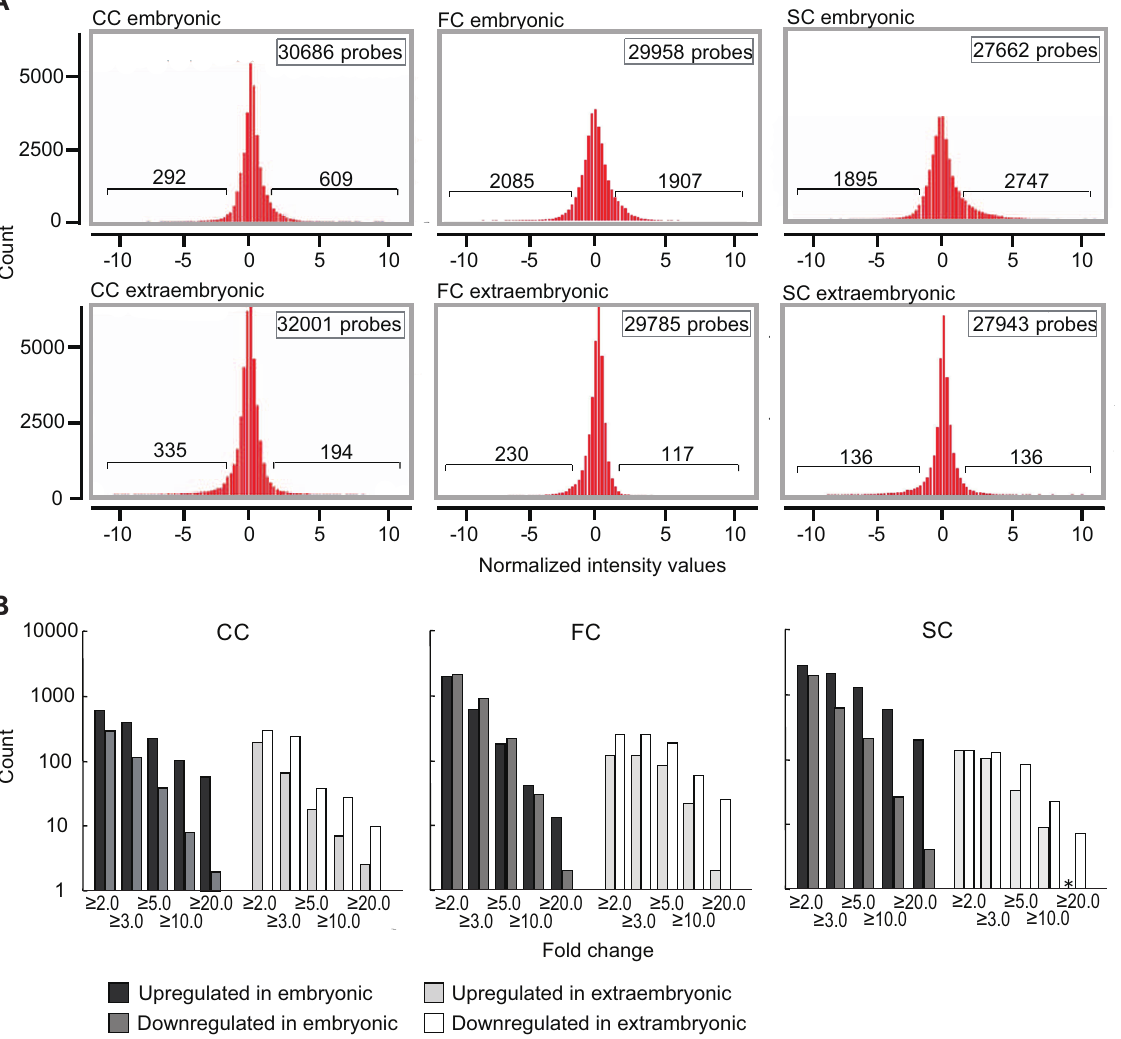
Figure 3. Fold change analysis of gene expression profiles of embryonic and extraembryonic samples. Fold change analysis with a cutoff of f . 2 identified the number of differentially expressed genes (DEGs) in SCNT-derived samples compared with IVF-derived controls. ( A ) Histogram showing the distribution of DEGs classified by the relative values compared with the IVF-derived controls. The embryonic samples included more DEGs (901–4642) than the extraembryonic samples (272–592). This tendency is depicted by the narrower and higher distribution patterns of the extraembryonic samples. ( B ) The cumulative numbers of up- and downregulated DEGs shown side-by-side based on fold changes. Dark and light bars represent up- and downregulated DEGs, respectively. In the embryonic tissues, large fold changes occurred predominantly with the upregulated DEGs, whereas in the extraembryonic tissues such changes occurred with the downregulated DEGs. *No corresponding gene.